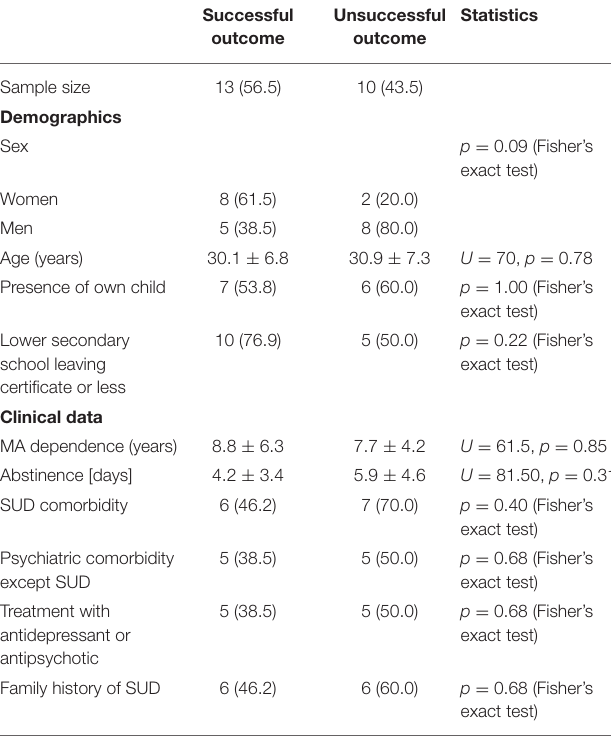
TABLE 2 | Comparison of subsamples with successful vs. unsuccessful